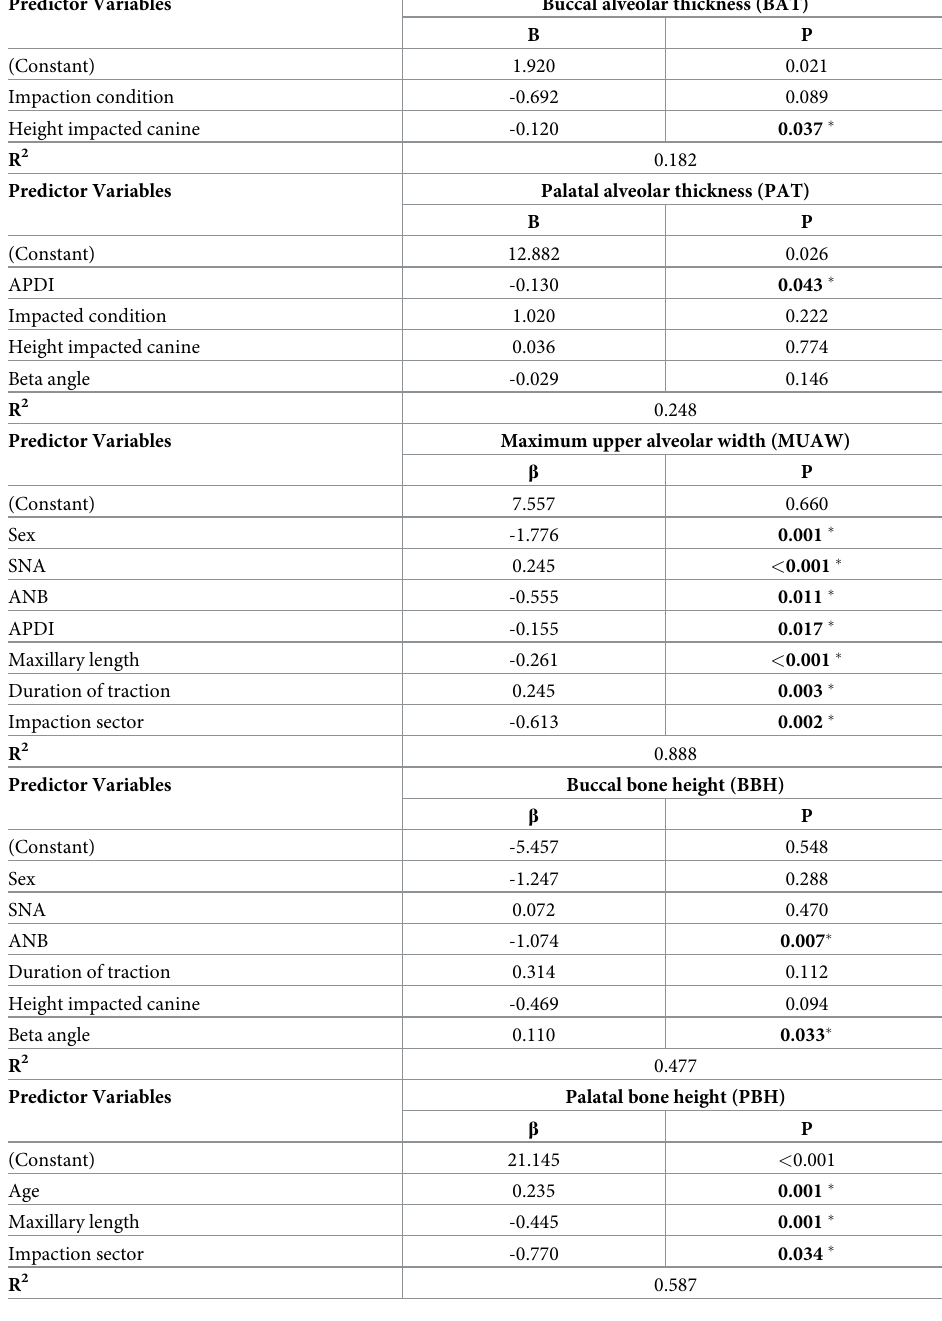
Table 7. Influence of predictor variables with P values smaller than 0.030 in the alveolar bone changes of PAMIC at coronal section (in